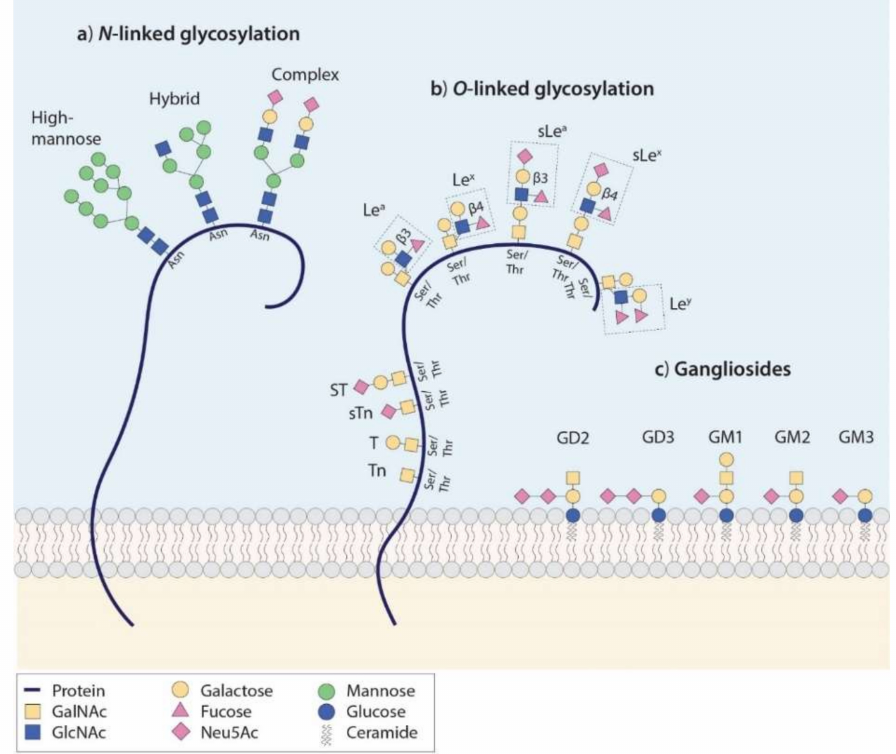
Figure 1. Schematic structures of oligosaccharides: ( a ) N-Linked glycans are covalently attached to proteins via asparagine (Asn). N -Glycans are assigned to three groups in which all share the same Pentasaccharide, Trimannosyl core structure: (1) High-Mannose N -glycans (2) Hybrid N -glycans in which the core is extended via both mannose and N -Acetylglucosamine (GlcNAc) residues and (3) complex N -glycans in which GlcNAc-initiated antennae are present. ( b ) O -linked glycans are covalently attached to proteins via Serine (Ser) or Threonine (Thr). Mucin-type O -Glycans are initiated by N -Acetylgalactosamine (GalNAc), while elongated, GlcNAc-containing glycans (displayed in dashed boxes) contribute to Type 1 (Gal β 1, 3GlcNAc) and Type 2 (Gal β 1, 4GlcNAc) structures. In this figure, sLe a and sLe x extend from a core 1 structure (Gal β 1–3GalNAc), while Le a , Le x , and Le y are attached to a core 2 structure (Gal β 1, 3[ β 1, 6lcNAc]GalNAc). Both N- and O- glycan antigens can carry N -Acetylneuraminic (Neu5Ac) acids, categorizing these structures as sialylated antigens. ( c ) Gangliosides consist of varying arrangement of sialic acid-containing glycan chain attached to the cell membrane via a lipid anchor, the ceramide. GM1 to GM3 are initiated by glucose and carry one sialic acid, while GD2 and GD3 carry two sialic